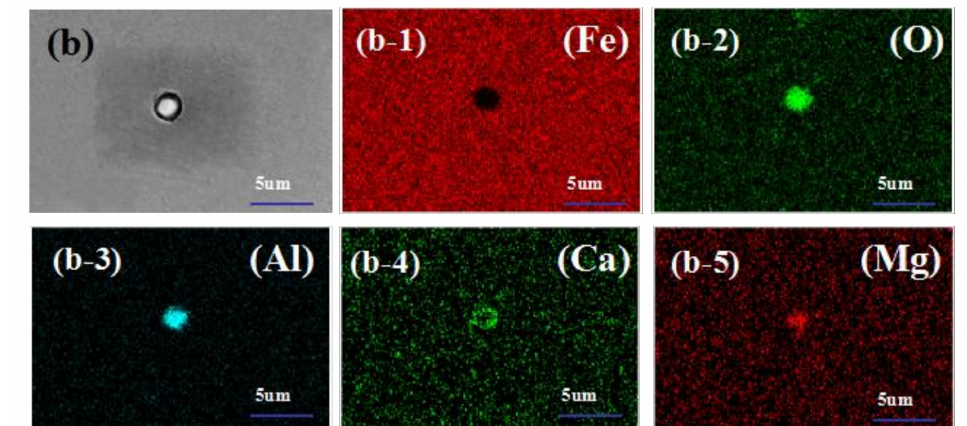
Figure 3. Scan of typical inclusions in H08A welding rod steel after calcium treatment (( a-1 – a-7 ) are element distribution maps of ( a ); ( b-1 – b-5 ) are element distribution maps of ( b )).